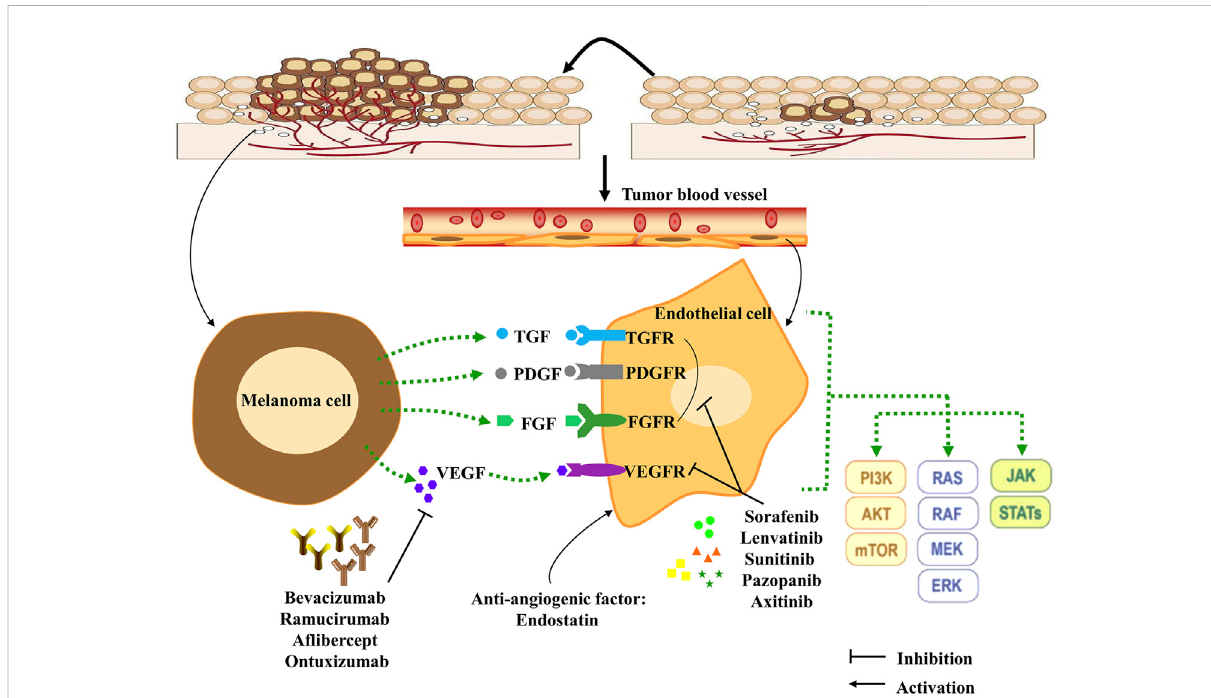
FIGURE 1 Angiogenesis, angiogenesis signaling pathways and anti-angiogenesis targets in melanoma cells. Pro-angiogenic factors are released by melanoma cells, and can bind receptors expressed on endothelial cells, which leads to initiation of the downstream signaling effects to stimulate melanoma proliferation, metastasis and differentiation. Combining this process with anti-angiogenesis compounds (monoclonal antibodies and TKIs) can effectively inhibit tumor angiogenesis. In addition, the anti-angiogenic factor Endostatin can interact with pro-angiogenic factors to in fl uence angiogenesis in the tumor microenvironment. TKIs: tyrosine kinase inhibitors; TGF: transforming growth factor; TGFR: transforming growth factor receptor; VEGF: Vascular endothelial growth factor; VEGFR: Vascular endothelial growth factor receptor; PDGF: Platelet-derived growth factor; PDGFR: Platelet-derived growth factor receptor; FGF: Fibroblast growth factor; FGFR: Fibroblast growth factor receptor; PI3K: Phosphoinositide 3-kinases; STAT: Signal transducer and activator of transcription protein; JAK: Janus protein tyrosine kinase; MEK: Mitogen- activated protein kinase; mTOR: Mammalian target of rapamycin.